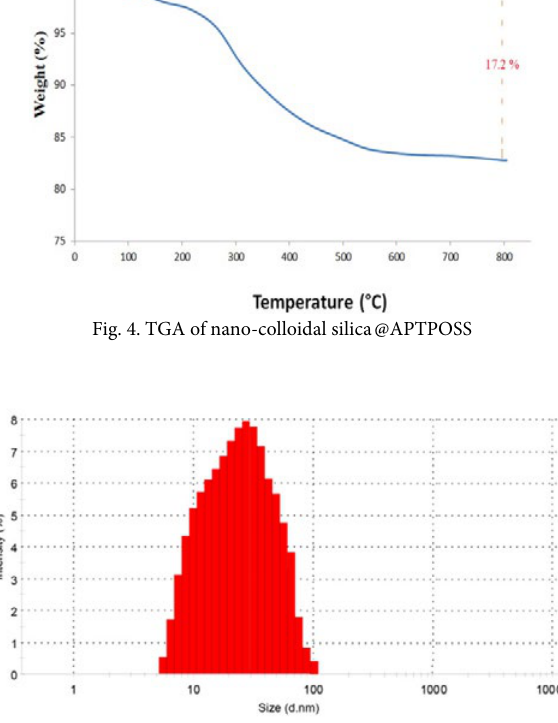
Fig. 5. DLS (dynamic light scattering) of nano-colloidal silica Fig. 5 . DLS (dynamic light scattering) of nano-colloidal silica @APTPOSS